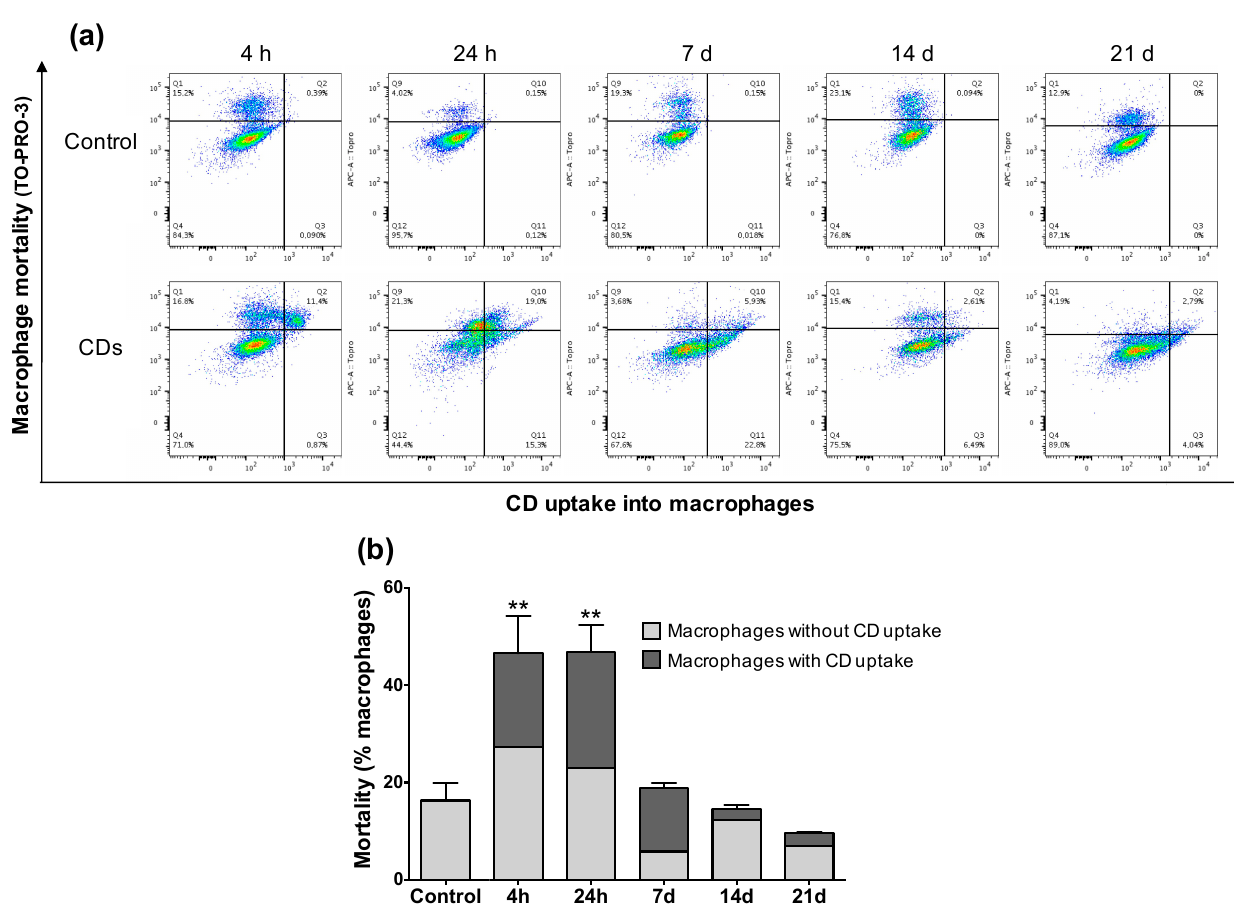
Figure 4. Alveolar macrophage mortality induced by CDs as a function of NP internalization as assessed by FACS. Mice received one administration of CDs (100 µg) or saline (control), and BALFs were collected 4 h, 24 h, 7 d, 14 d, or 21 d later. ( a ) CD-associated fluorescence (X-axis) as a function of TO-PRO-3 fluorescence (Y-axis) at the 4-h, 24-h, 7-d, 14-d, or 21-d time points (data from n = 1 mouse for each panel). ( b ) Kinetics of alveolar macrophage mortality in line with CD uptake. Data are means ± SEM of n = 3 mice. Statistical differences when compared to controls were determined by ANOVA followed by the Dunnett’s test, ** p < 0.01.